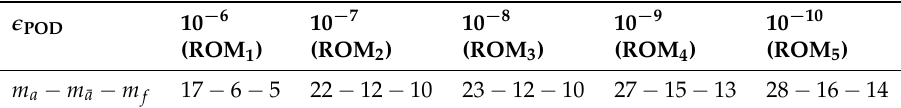
Figure 2. Vector and matrices’ snapshots spectrum. Left is the vector f , middle the matrix K dd , and right the matrix K aa . Table 1. ROM